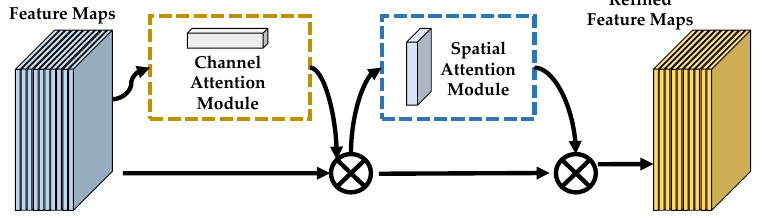
Figure 2. The architecture of the